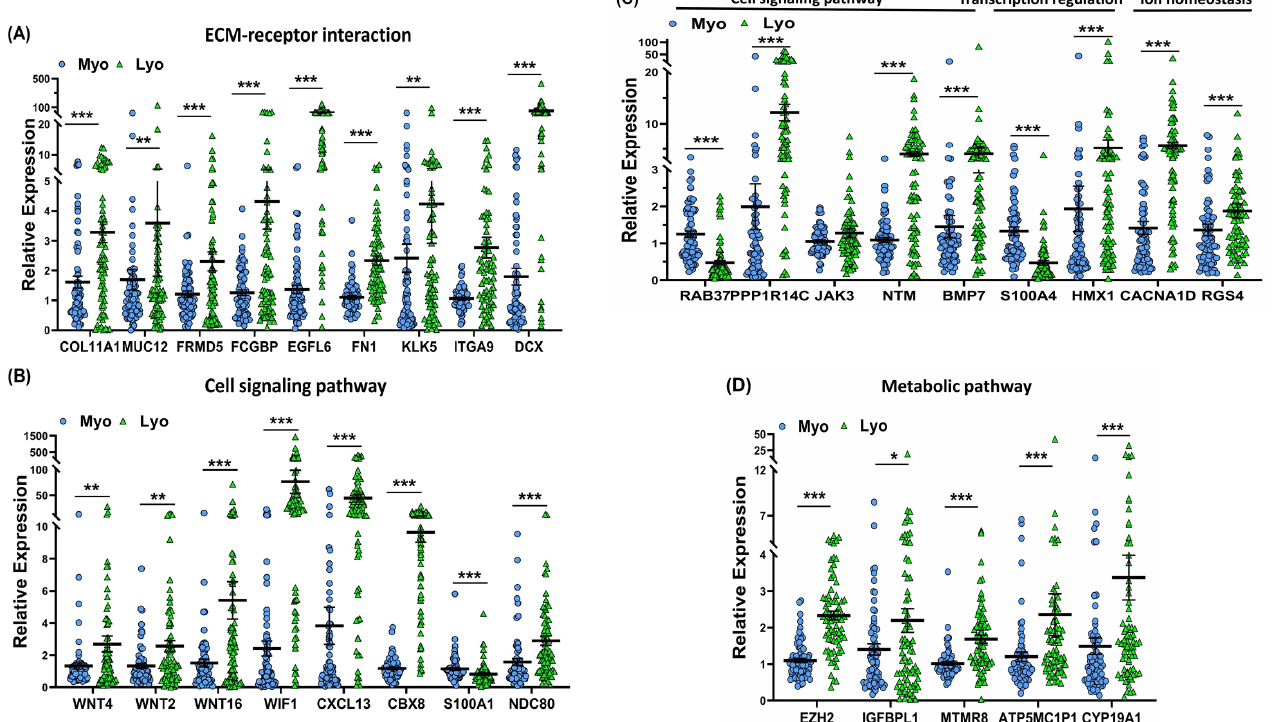
Figure 5. The expression of selected genes from the analysis between myometrium and paired leiomyomas (n = 73) measured using qRT-PCR. ( A ) COL11A1 , MUC12 , FRMD5 , FCGBP , EGFL6 , FN1 , KLK5 , ITGA9 , and DCX ; ( B ) WNT4 , WNT2 , WNT16 , WIF1 , CXCL13 , CBX8 , S100A1 , and NDC80 ; ( C ) RAB37 , PPP1R14C , JAK3 , NTM , BMP7 , S100A4 , HMX1 , CACNA1D , and RGS4 ; ( D ) EZH2 , IGFBPL1 , MTMR8 , ATP5MC1P1 , and CYP19A1 . The results are presented as mean ± SEM with p values (* p < 0.05; ** p < 0.01; *** p < 0.001) indicated by corresponding lines.